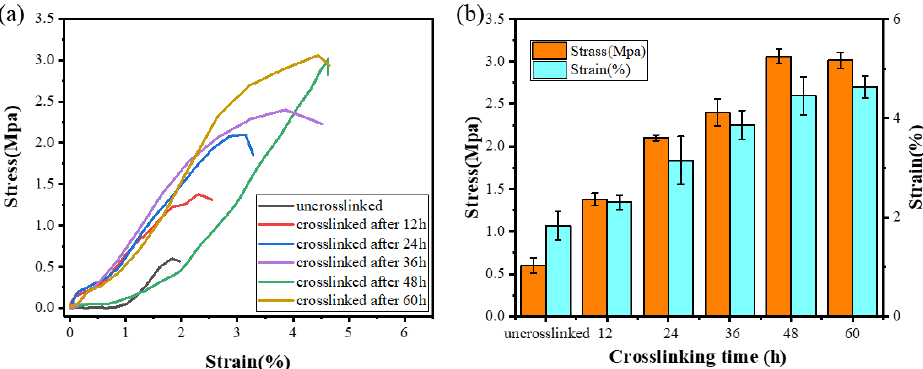
Figure 5. ( a ) Stress–strain curves of the γ -PGA/keratin ENS under different cross-linking times. ( b ) Maximum stress and breaking elongation of the γ -PGA/keratin ENS under different cross-linking times.